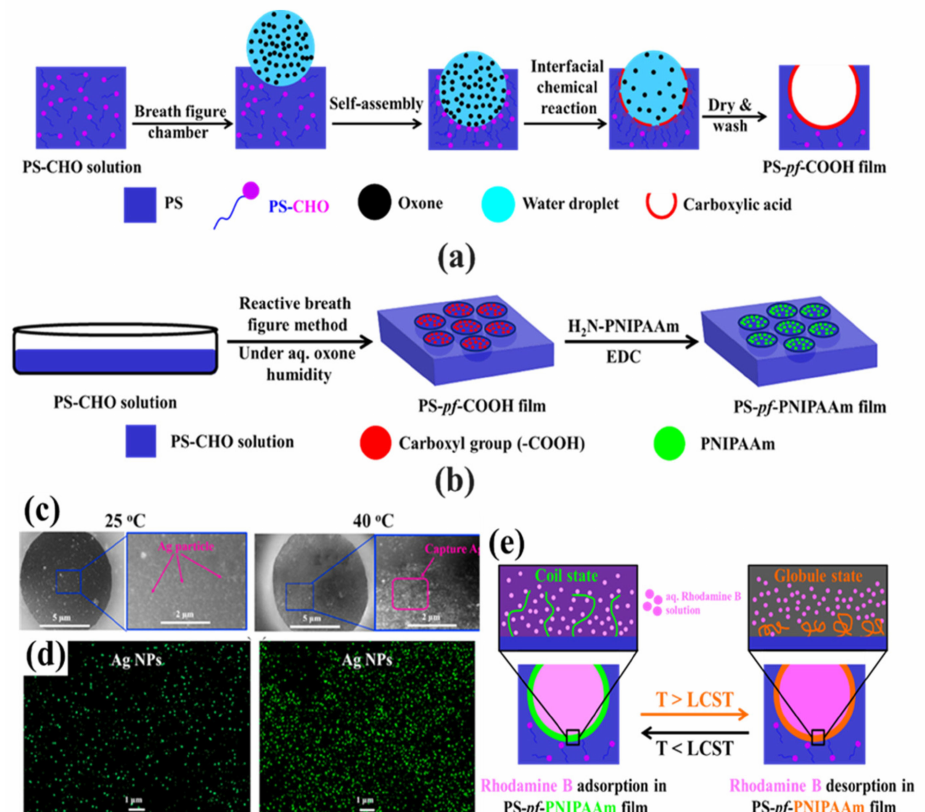
Figure 19. ( a ) The possible mechanism involved in the rBF process via self-assembly process ac- companying an interfacial chemical reaction between formylated PS and oxone at the interface of the water droplet/polymer solution. ( b ) Schematic process for the preparation of pore-selective PNIPAAm modified (PS-pf-PNIPAAm) film by the reaction between PS-pf-COOH film and an aq. H 2 N-PNIPAAm solution in the presence of EDC. ( c , d ) SEM images and elemental mapping show the capture of Ag particles at 25 ◦ C and 40 ◦ C. Reprinted with permission from ref. [112] Copyright 2020 Polymer. ( e ) Scheme showing the release of rhodamine B at the LCST of PNIPAAm. Reprinted with permission from ref. [115] Copyright 2021 Polymer